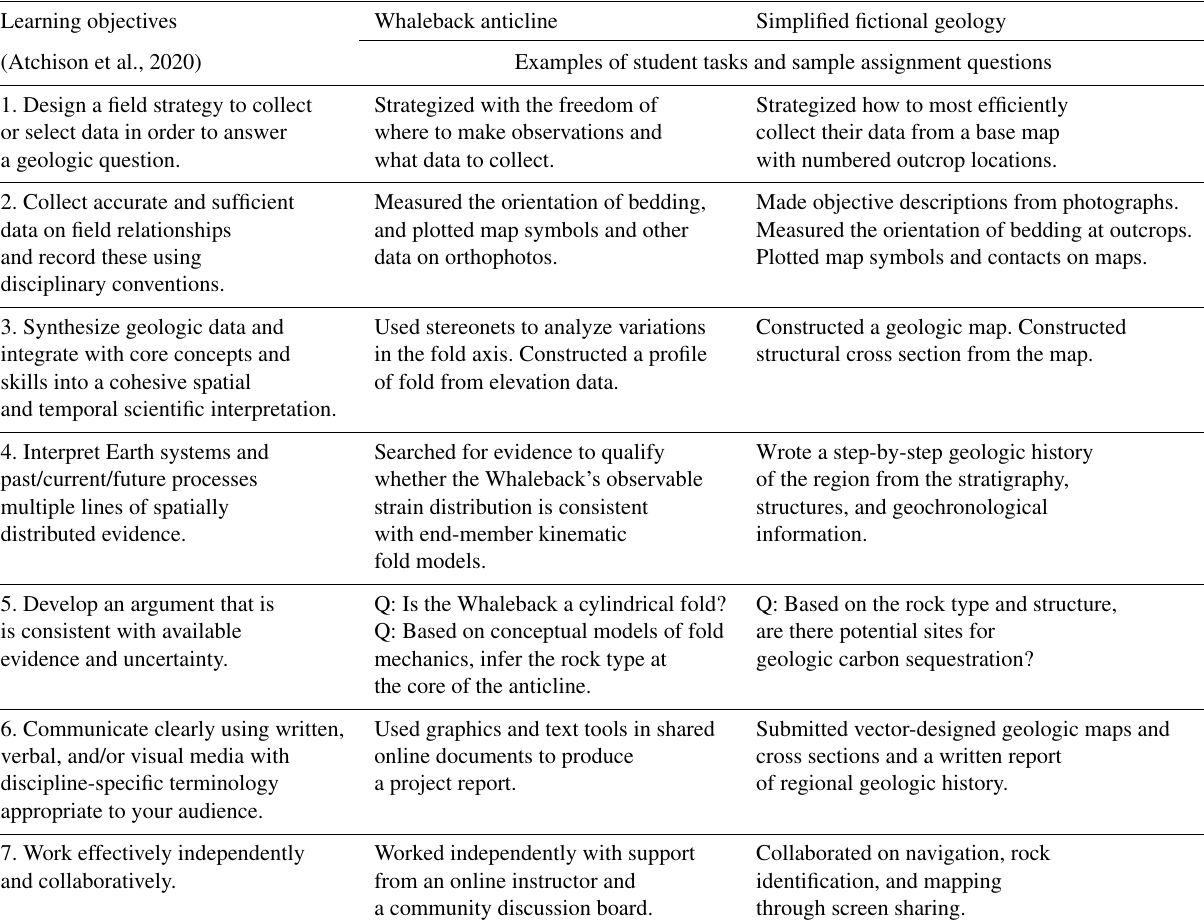
Table 1. Learning outcomes from the National Association of Geoscience Teachers and the International Association for Geoscience Diver- sity (Atchison et al., 2020) and the assignments associated with our two virtual field